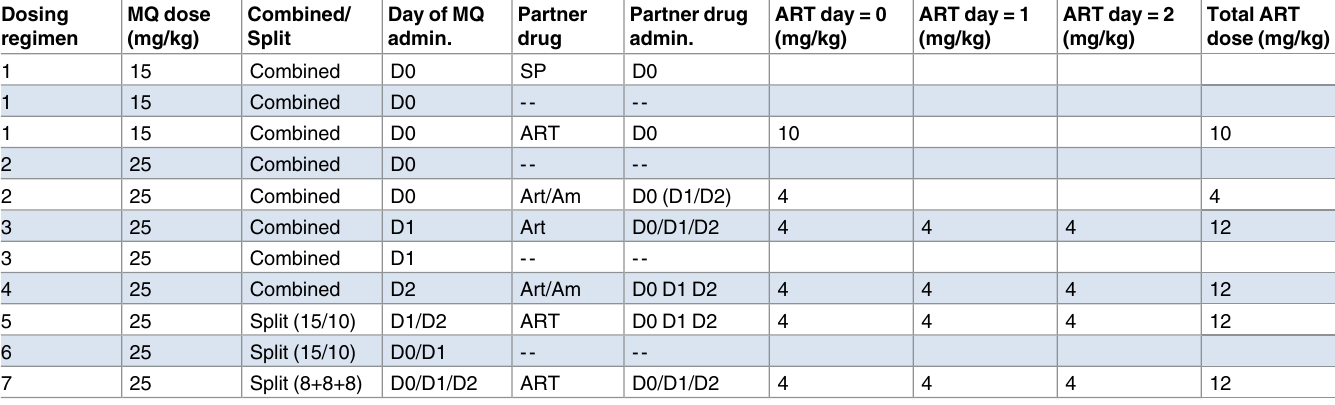
Table 1. The timing and total dose of MQ (mefloquine) and artesunate from 18 SMRU studies. Dosing MQ dose regimen